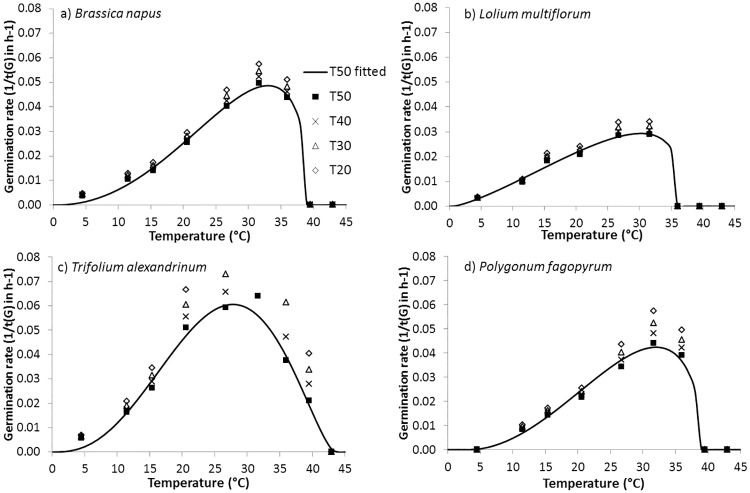
Curves fit to observed germination rates for four fractions percentages of the seed population, 20% (◊), 30% (Δ), 40% (x) and 50% (■), according to temperature, for Brassica napus (Brassicaceae), Lolium multiflorum (Poaceae), Trifolium alexandrinum (Fabaceae) and Polygonum fagopyrum (Polygonaceae).